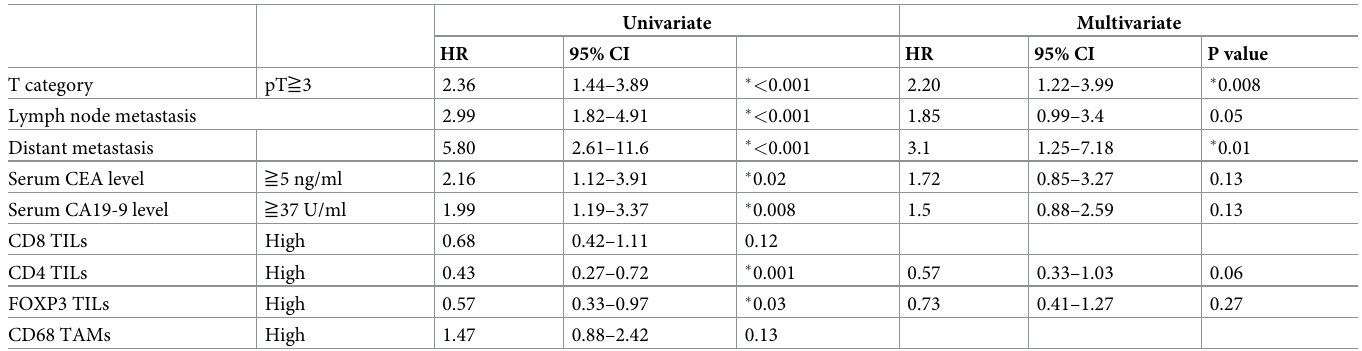
Table 5. Univariate and multivariate cox regression analysis for recurrence free survival in 130 patients with BTC.